Question: Reading the figure, is the described quantity rising or falling?
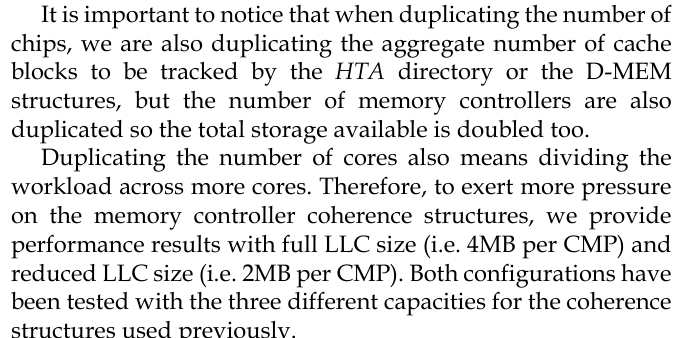
Answer: increasing